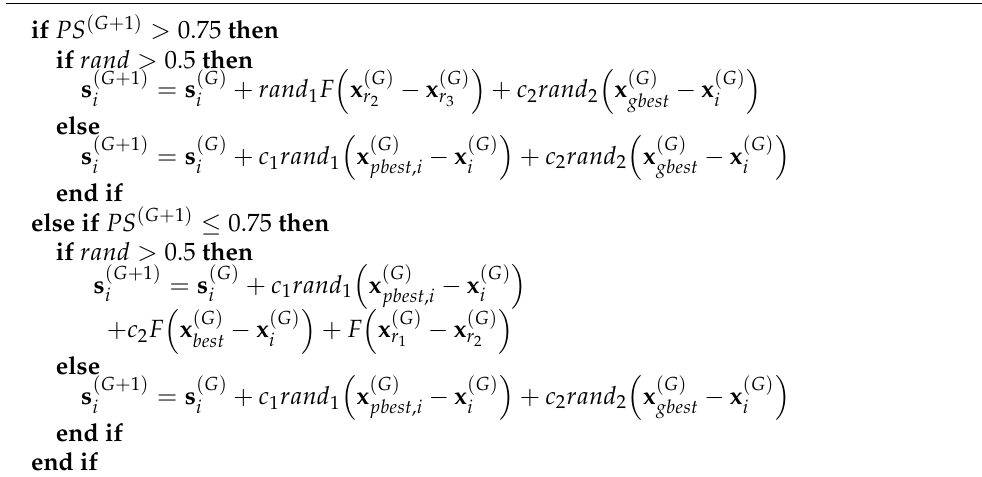
Algorithm 2 Presudocode of the velocity update equation of the hybrid